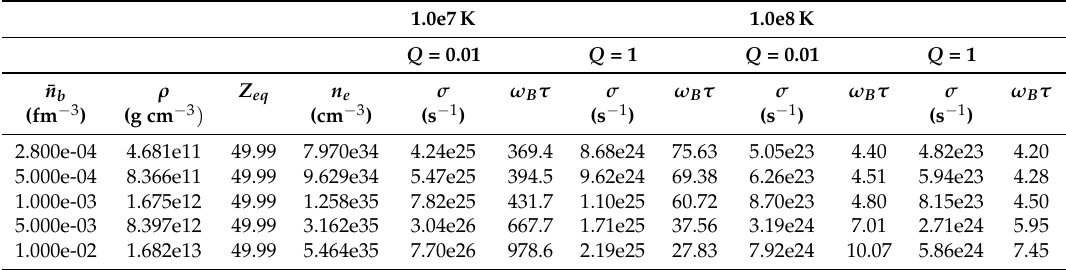
Table 4. Same as in Table 3, for the nuclear mass model HFB-25 (Cited from Person et al. (2008).